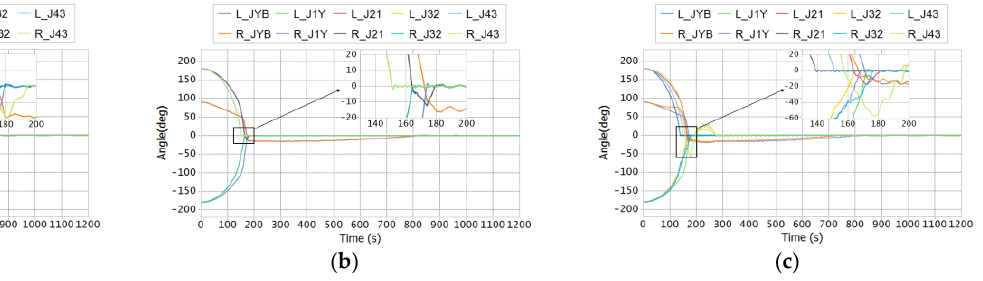
Figure 8. Rotation angles of TSHs in deployment: ( a ) by rigid body; ( b ) by MORM; ( c ) by FEM. The acceleration of the middle point of panel edge was measured to investigate the